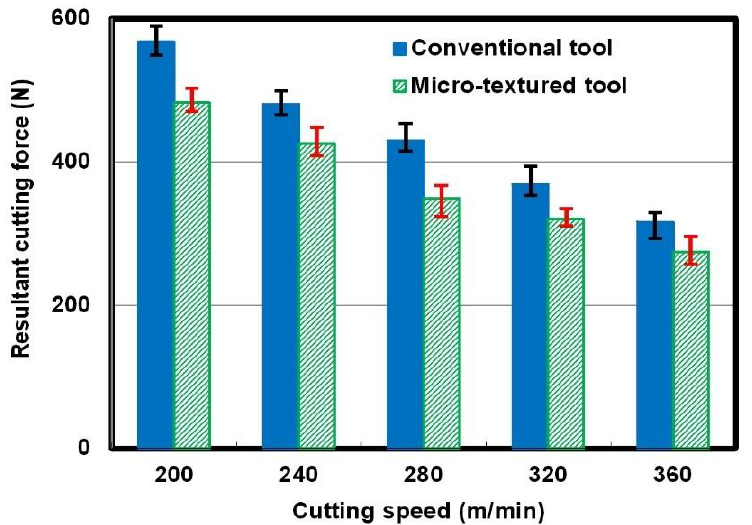
Figure 2. Resultant cutting forces of the micro-textured tool and the conventional tool at different cutting speeds.